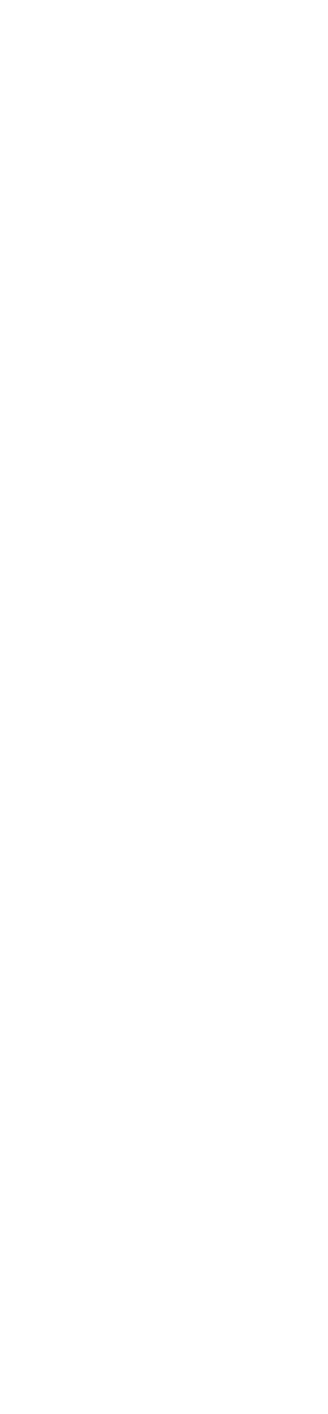
Earth Syst. Dynam., 13, 1557–1609, 2022